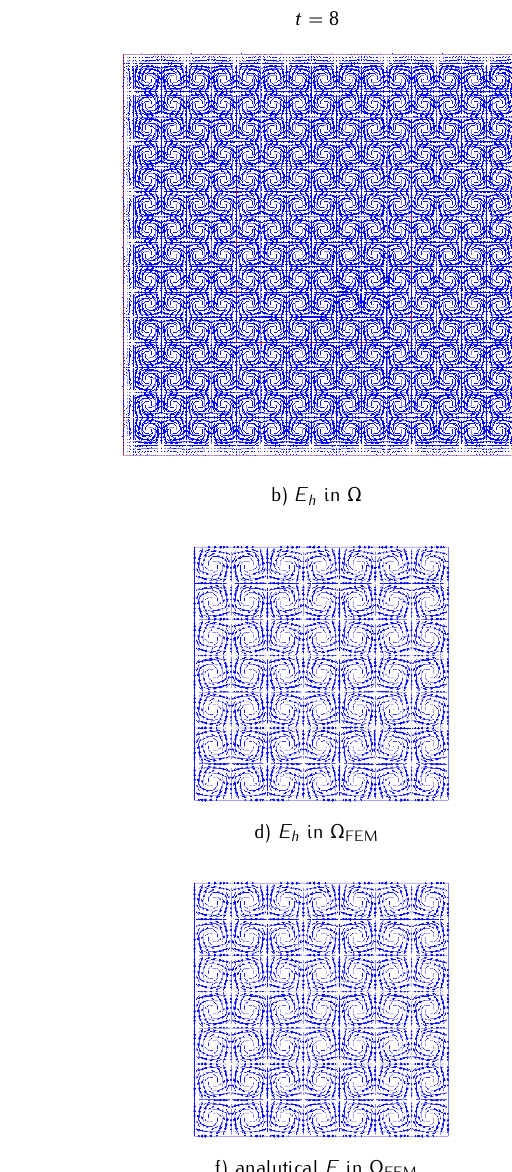
in the domain ,E 1 h 2 h ) is shown in Ω . In e) and f) the analytical ,E 1 h 2 h ) FEM